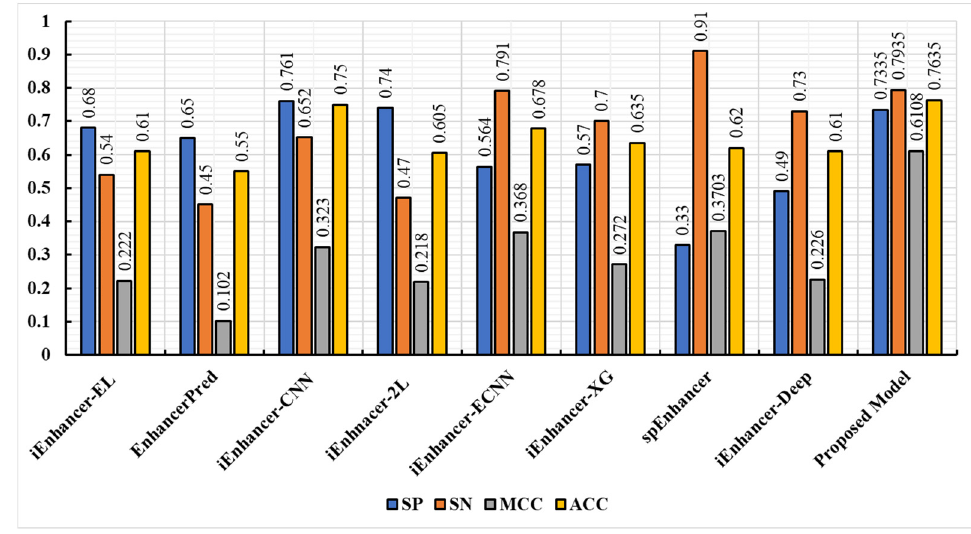
Figure 8. Comparison of the proposed model’s performance against state-of-the-art predictors in the second stage.